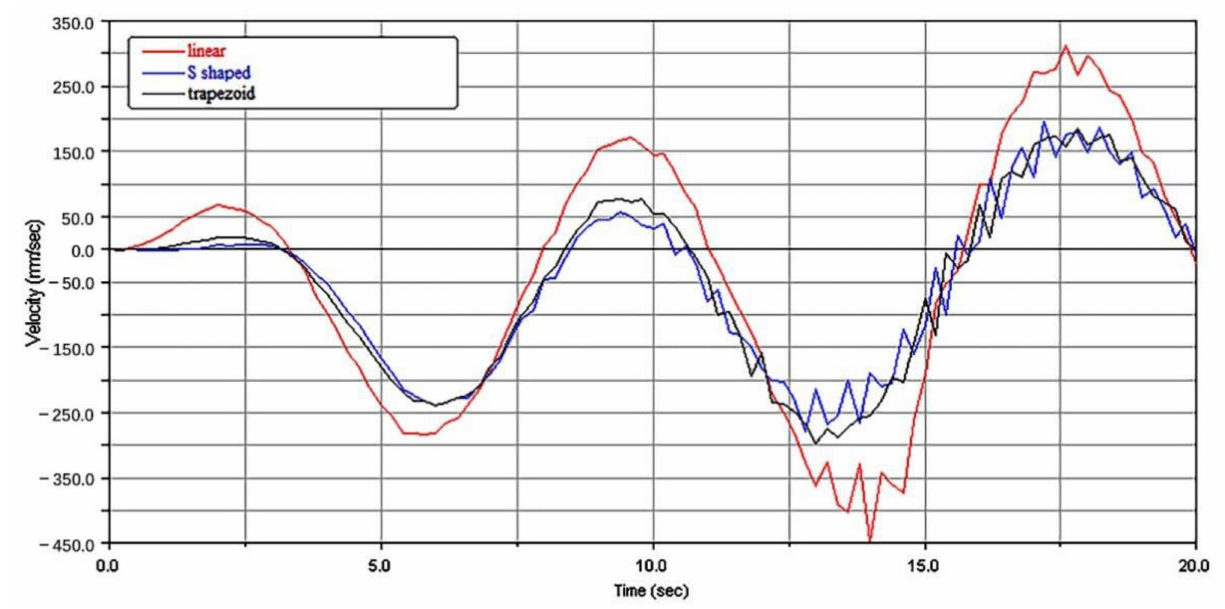
Figure 10. End speed distribution in different drive